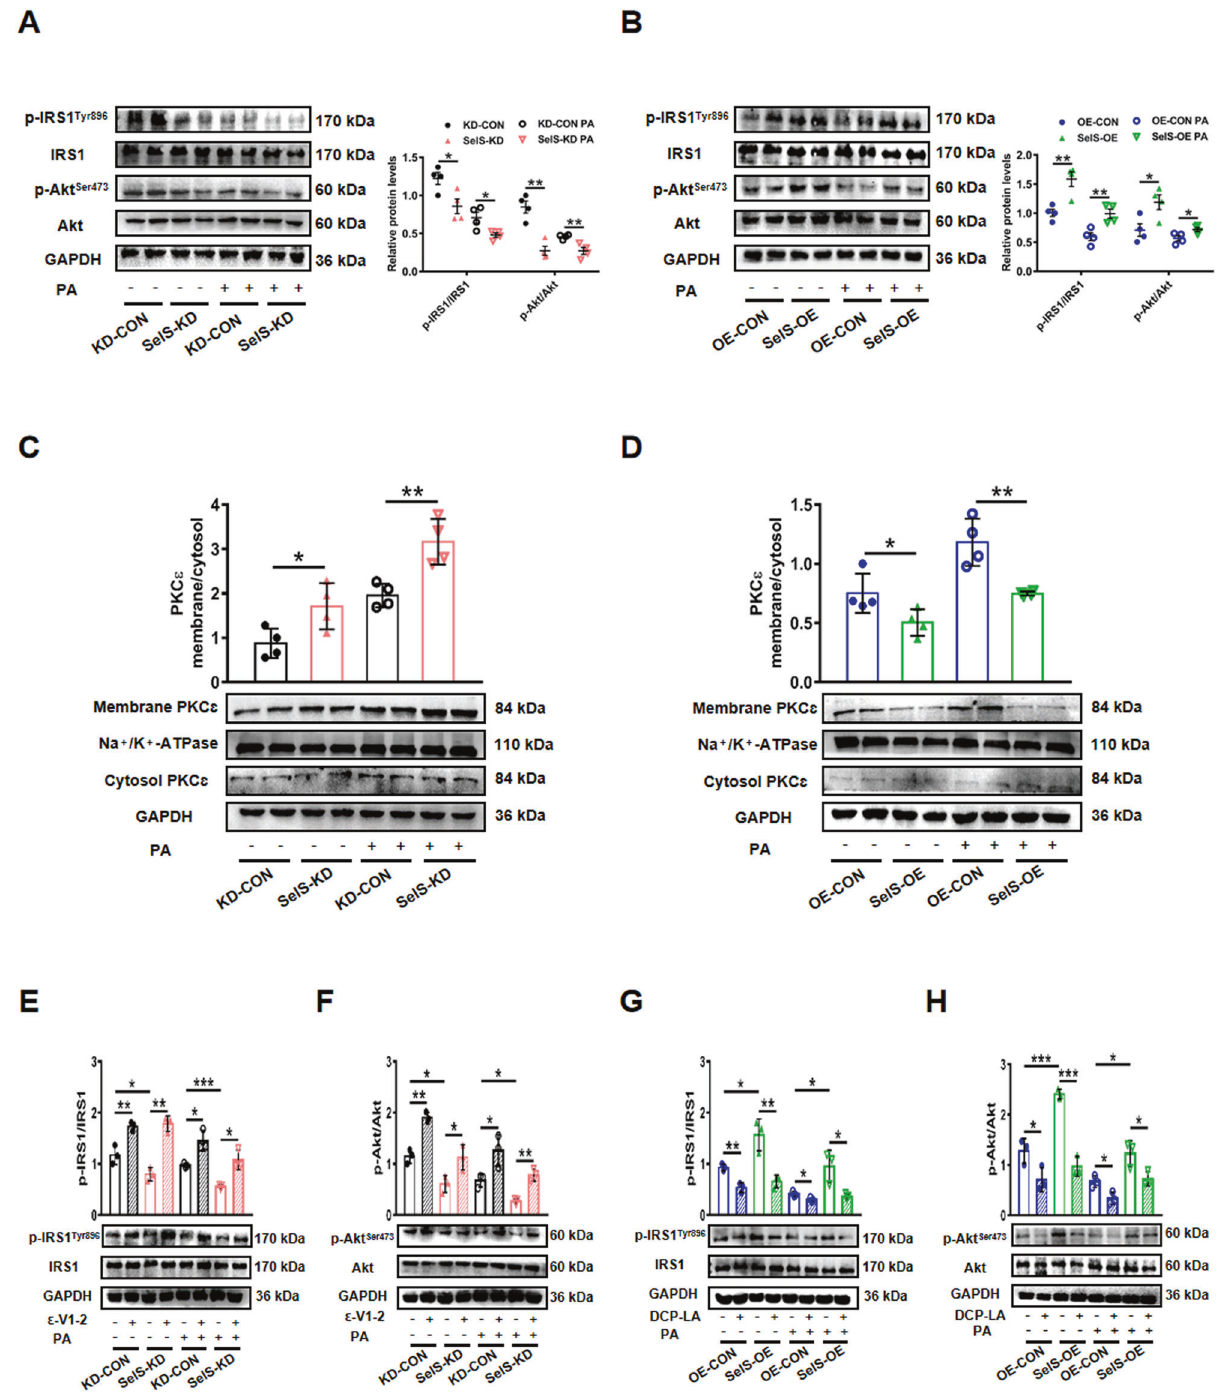
Fig. 6 SelS promotes hepatic insulin signaling via decreased PKC ɛ activation in vitro. A , B The phosphorylation and total protein levels of IRS1 and Akt in SelS-KD and KD-CON ( A ), SelS-OE and OE-CON ( B ) primary hepatocytes treated with 0.5 mM PA or BSA for 24 h ( n = 4 per group). Representative Western blotting images from 2 samples out of 4 for each group are shown. C , D Membrane/cytosol ratio of hepatic PKC ɛ protein levels normalized with housekeeping proteins Na + /K + -ATPase and GAPDH in SelS-KD and KD-CON ( C ), SelS-OE and OE-CON ( D ) primary hepatocytes treated with 0.5 mM PA or BSA for 24 h ( n = 4 per group). Representative images from two samples out of 4 for each group are shown. E – H After infection, the primary hepatocytes were preincubated with PKC ɛ inhibitor ( ε -V1-2, 1 μ M) in SelS-KD and KD-CON groups ( E , F ) or PKC ɛ activator (DCP-LA, 100 nM) in SelS-OE and OE-CON groups ( G , H ) for 1 h before stimulated with 0.5 mM PA or BSA for 24 h. The phosphorylation and total protein levels of IRS1 and Akt were examined by Western blotting in the indicated groups ( n = 3 per group). Representative images from one sample out of 3 for each group are shown. All data are presented as the mean ± SEM. * P < 0.05, ** P < 0.01, *** P < 0.001. SelS-KD/KD-CON, SelS knockdown and the corresponding control; SelS-OE/OE-CON, SelS overexpression and the corresponding control; IRS1, insulin receptor substrate 1; Akt/PKB, protein kinase B; PKC ɛ , protein kinase C ɛ .